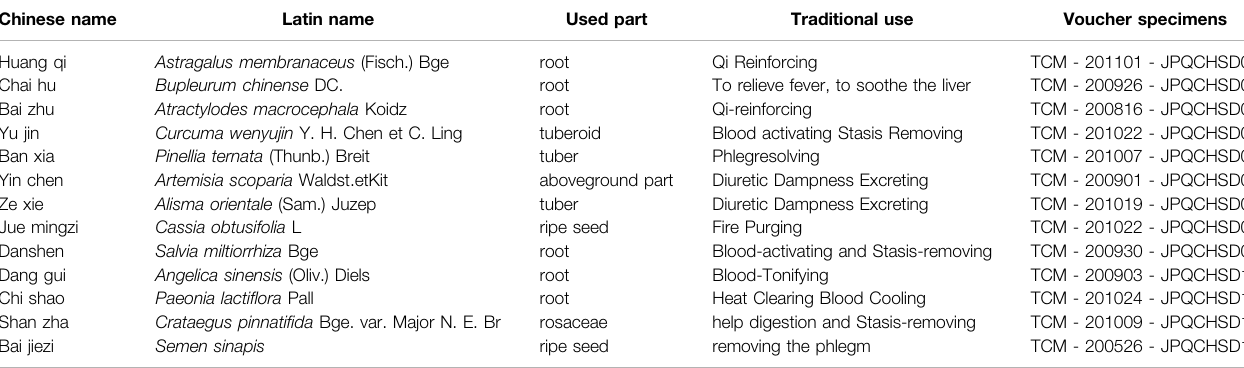
TABLE 1 | Different components in the formula of